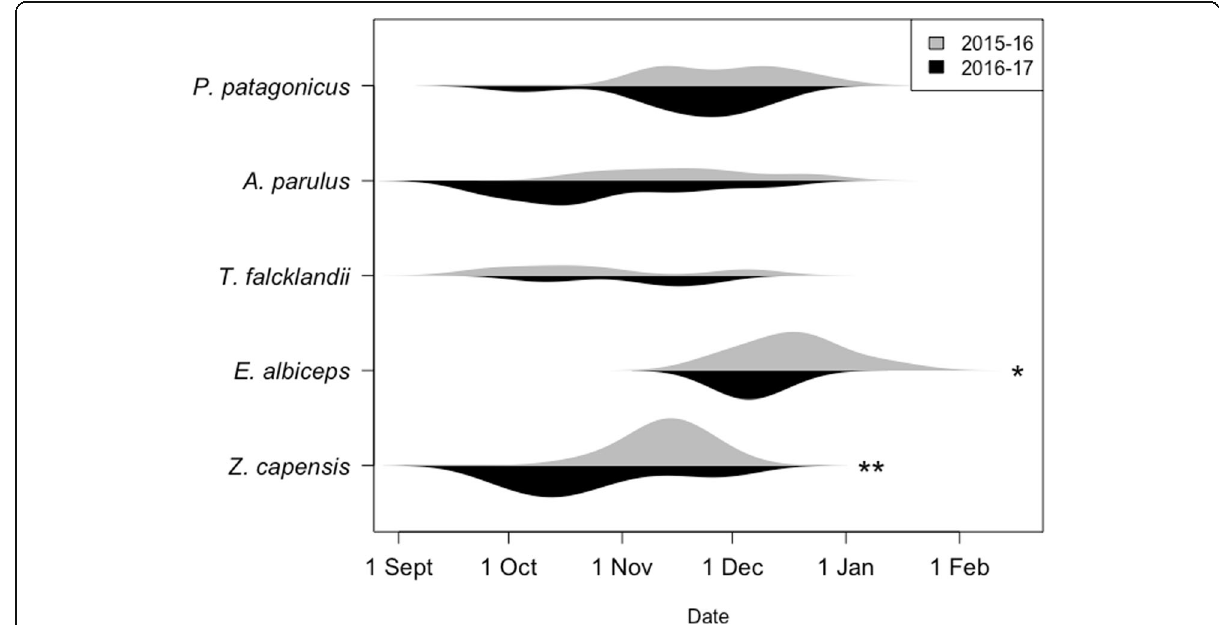
Fig. 2 Egg-laying date for five open-cup forest-nesting birds that breed on Navarino Island, southern Chile. Sample sizes per season are as follows: P. patagonicus 2015 – 16 = 7 and 2016 – 17 = 9, A. parulus 2015 – 16 = 5 and 2016 – 17 = 9, T. falcklandii 2015 – 16 = 4 and 2016 – 17 = 3, E.